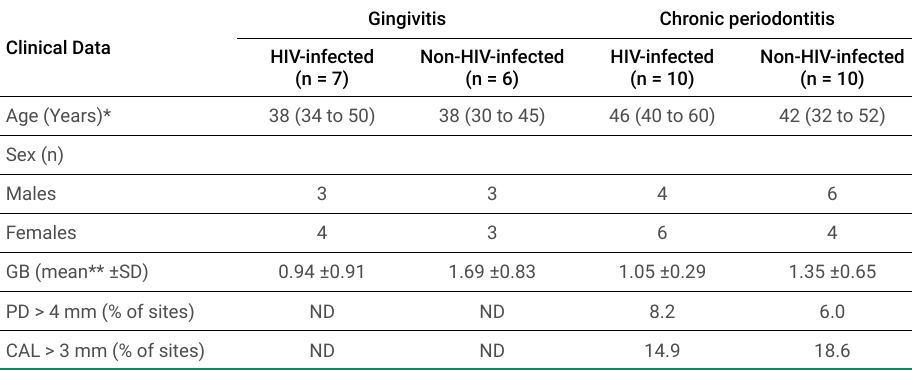
Table 1. Data clinical and periodontal clinical parameters of the HIV-infected and non-HIV-infected individuals. Clinical